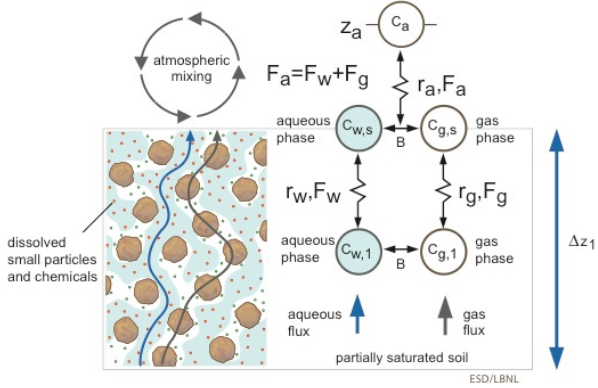
Figure 1 . A schematic of the topsoil control volume (TSCV), interface, and atmospheric 2 Fig. 1. A schematic of the topsoil control volume (TSCV), interface, and atmospheric or canopy air concentrations used to estimate air– or canopy air concentrations used to estimate air-soil exchange of generic volatile tracers. 3 soil exchange of generic volatile tracers. The atmospheric mixing The atmospheric mixing here includes both eddy mixing and molecular diffusive mixing. 4 here includes both eddy mixing and molecular diffusive